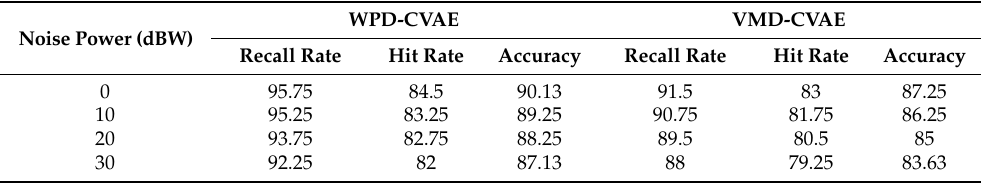
Table 7. Performance comparison under different noise power